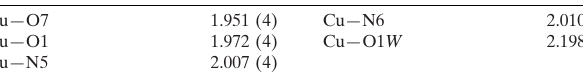
Selected bond lengths (A˚ ).